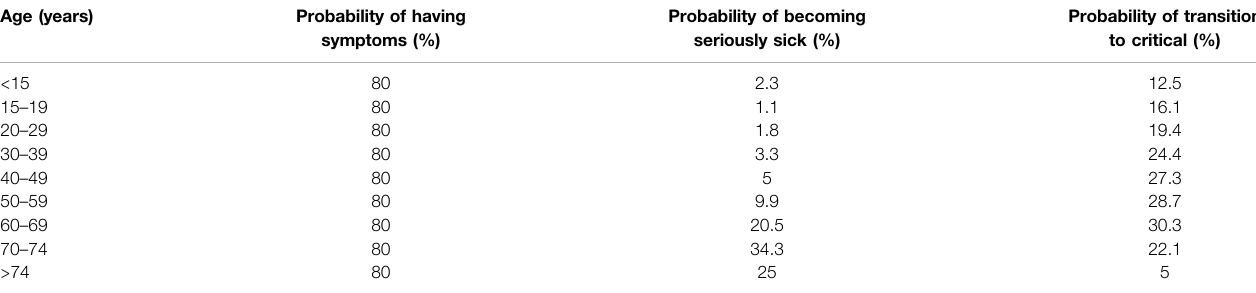
Age (years) Probability of having